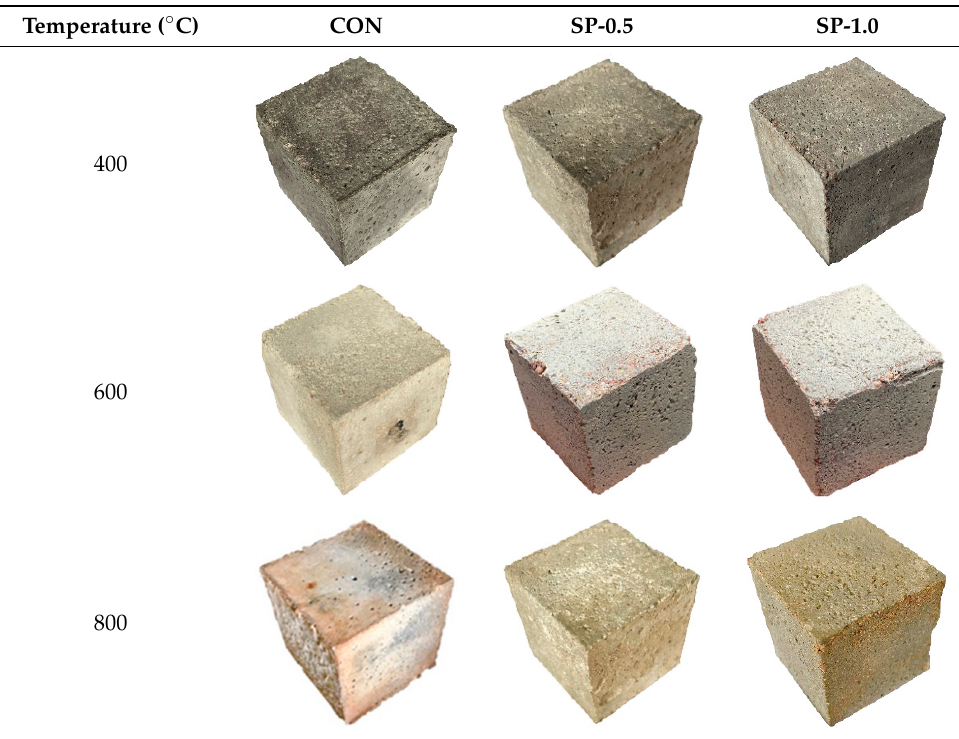
Table 5. Surface characteristics of specimens after being subjected to heat.